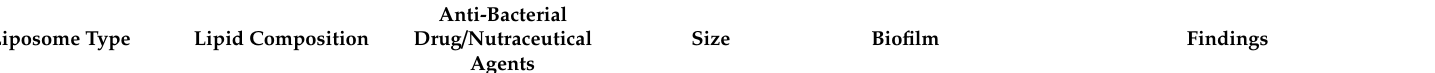
Table 1. Examples on recently published studies on di ff erent types of liposomes used against bacterial biofilm